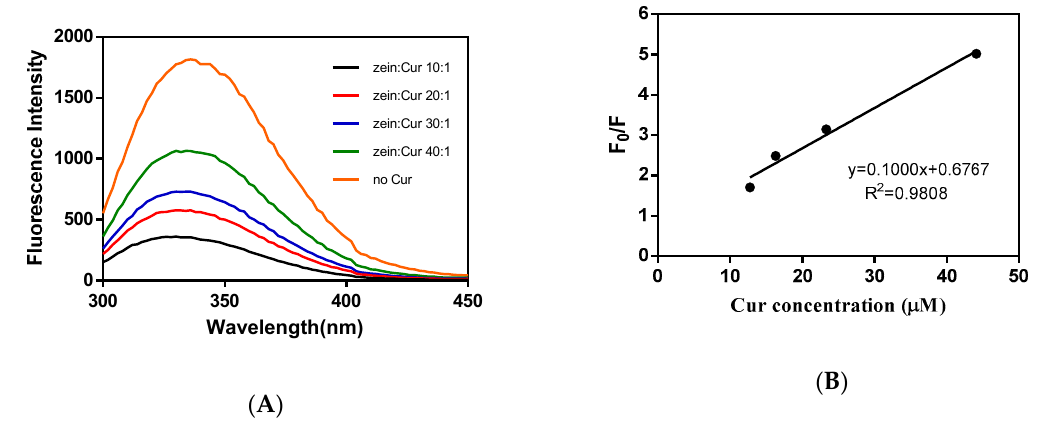
Figure 5. Changes in fluorescence emission spectra of blank zein ‐ caseinate ‐ pectin particles and Cur ‐ loaded zein ‐ caseinate ‐ pectin particles with different zein to Cur mass ratios ( A ); linear relationship of F 0 /F versus Cur concentration in the Stern–Volmer equation ( B ).